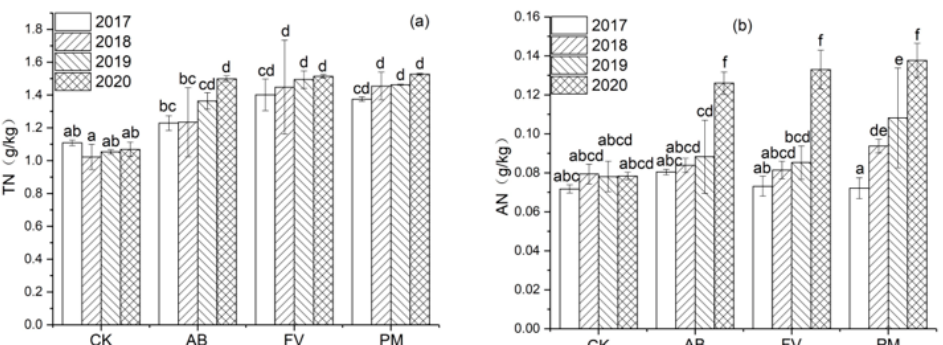
Figure 2. ( a ) Effects of the different fertilizer treatments on the content of TN in the soils; ( b ) Effects of the different fertilizer treatments on the content of AN in the soils. All the data are expressed as means ± SD; n = 3. Different letters on data in the same group indicate a significant difference between them at p < 0.05 level.